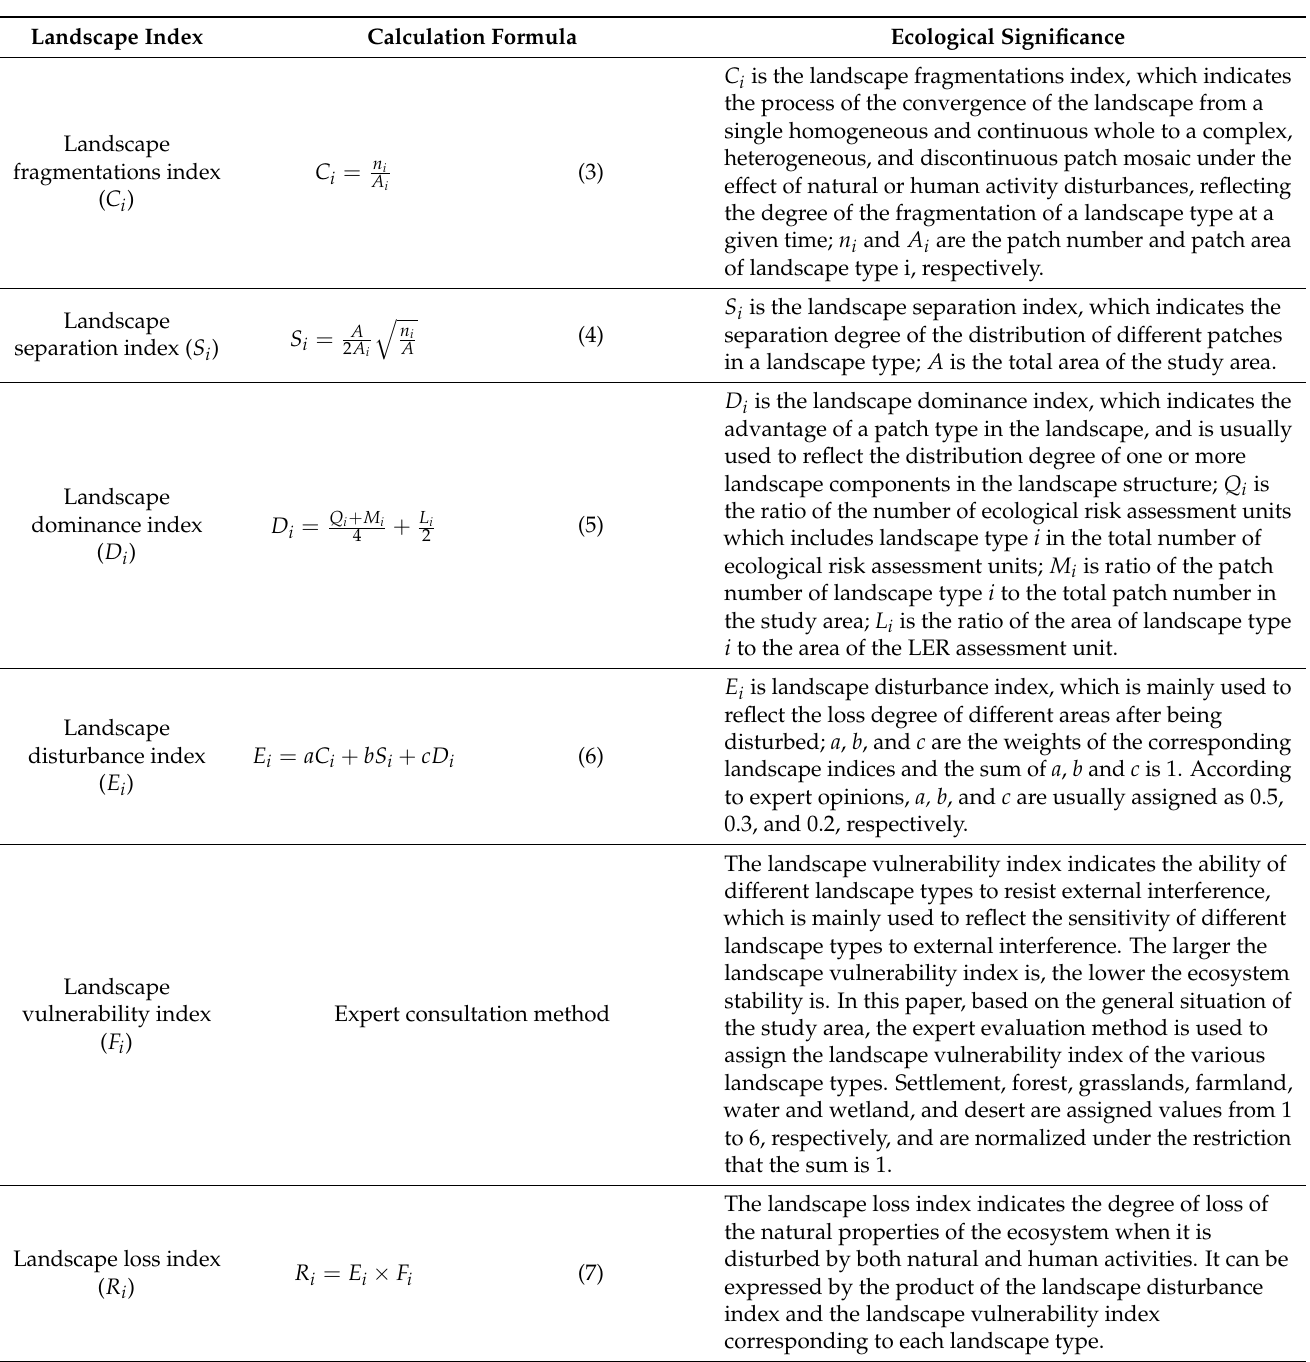
Table 1. Calculation formula of each landscape index and corresponding ecological